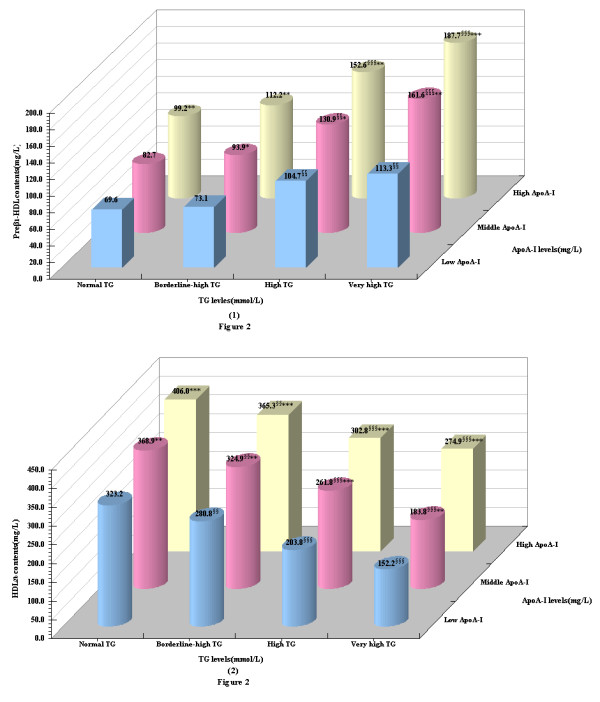
The contents of preβ1-HDL(1) and HDL2b(2) according to TG and apoA-I concentration for the whole subjects. *P< 0.05,**P< 0.01, ***P< 0.001, compared with the low apoA-I subgroup within the same TG group§§P< 0.01, §§§P< 0.001, compared with the normal TG subgroup within the same apoA-I group